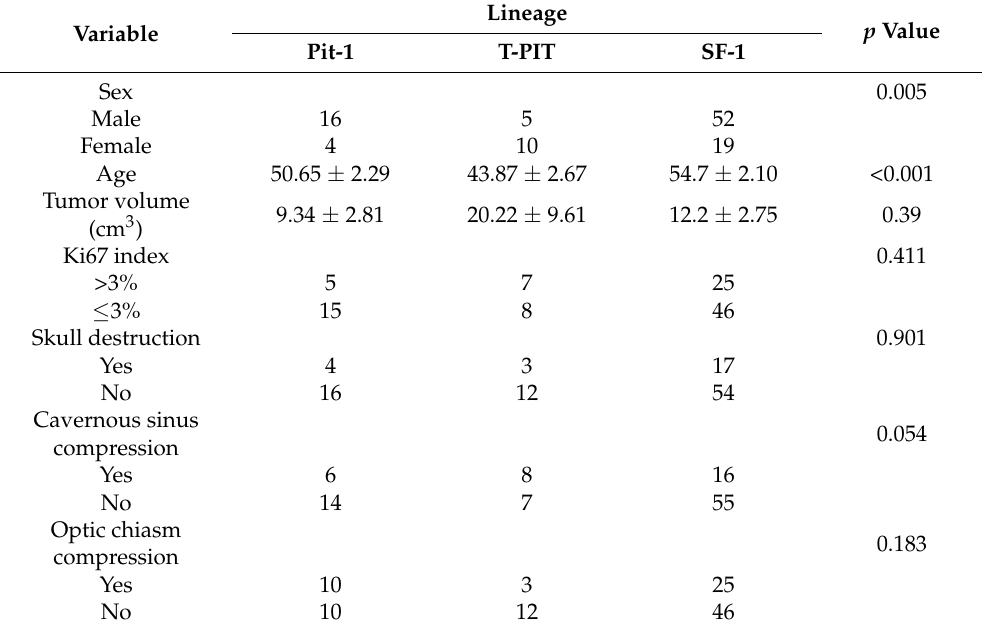
Table 1. The clinical characteristics in 106